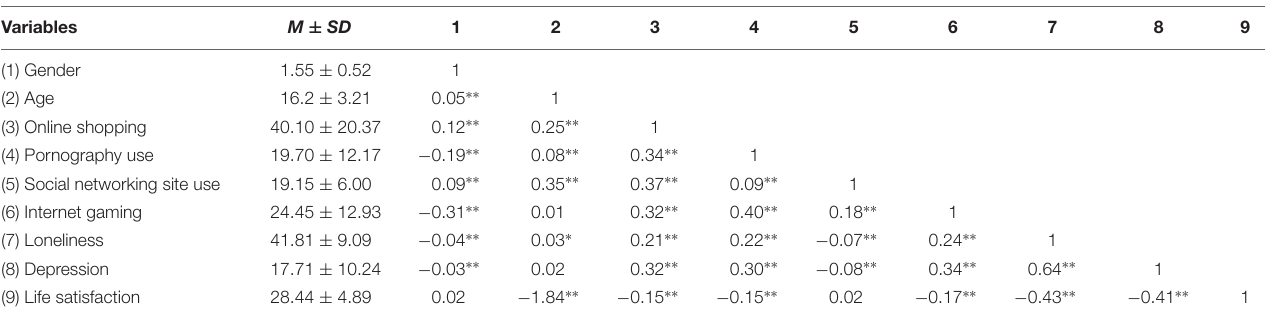
TABLE 1 | Means, standard deviations, and Pearson correlations of studied variables.